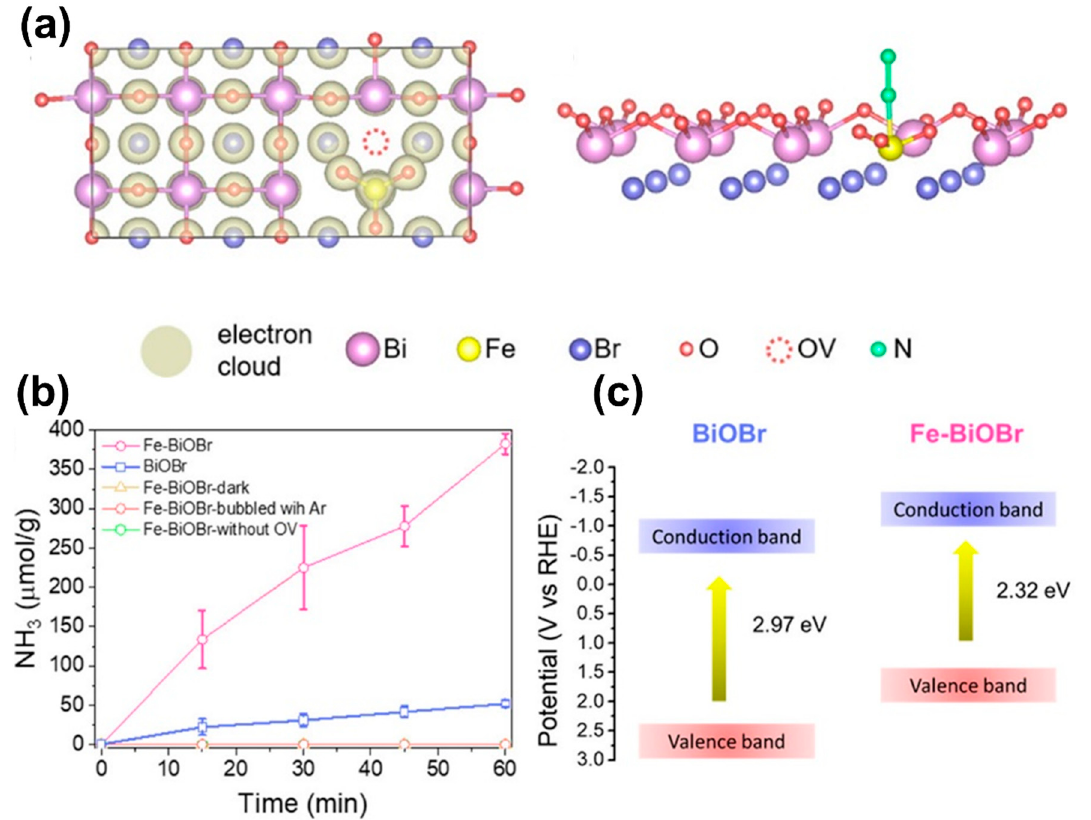
Figure 9. ( a ) Charge density map of Fe-doped BiOBr nanosheets and the schematic of N 2 binding to the oxygen vacancy connected Fe atom in Fe-BiOBr, ( b ) plot depicting the photocatalytic NH 3 generation using Fe-doped BiOBr nanosheets and ( c ) band structure of BiOBr and Fe-doped BiOBr nanosheets. Reprinted from Ref. [209] with permission from American Chemical Society.